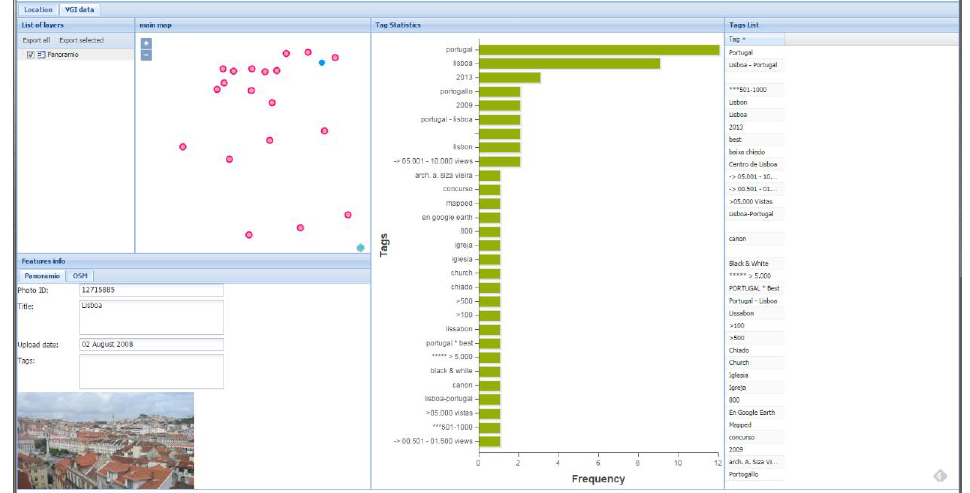
Figure 5. Features dashboard for the photo interpretation use case (note: red dots represent Panoramio photo locations, selected dots are highlighted in blue, and the green bars show the frequency of each tag).